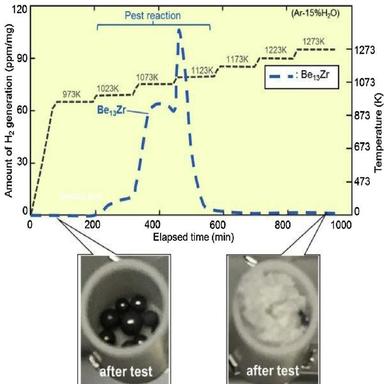
Hydrogen generation amount of the Be13Zr pebbles with 1, 5, and 10 wt.% of Si compared to the as-granulated Be13Zr pebbles, and photographs of specimens before and after the test.